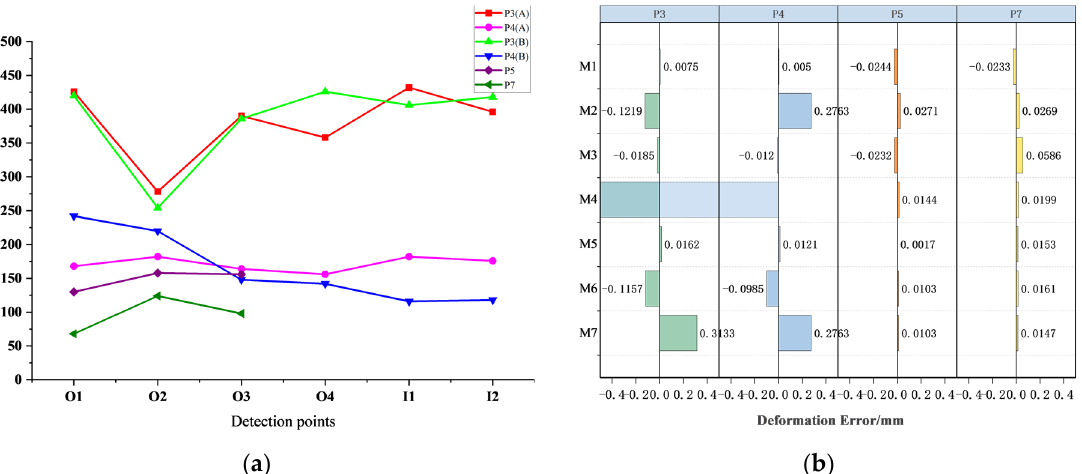
Figure 6. Residual stress distribution and deformation of 1# under different processes: ( a ) Residual stress; ( b ) Deformation.